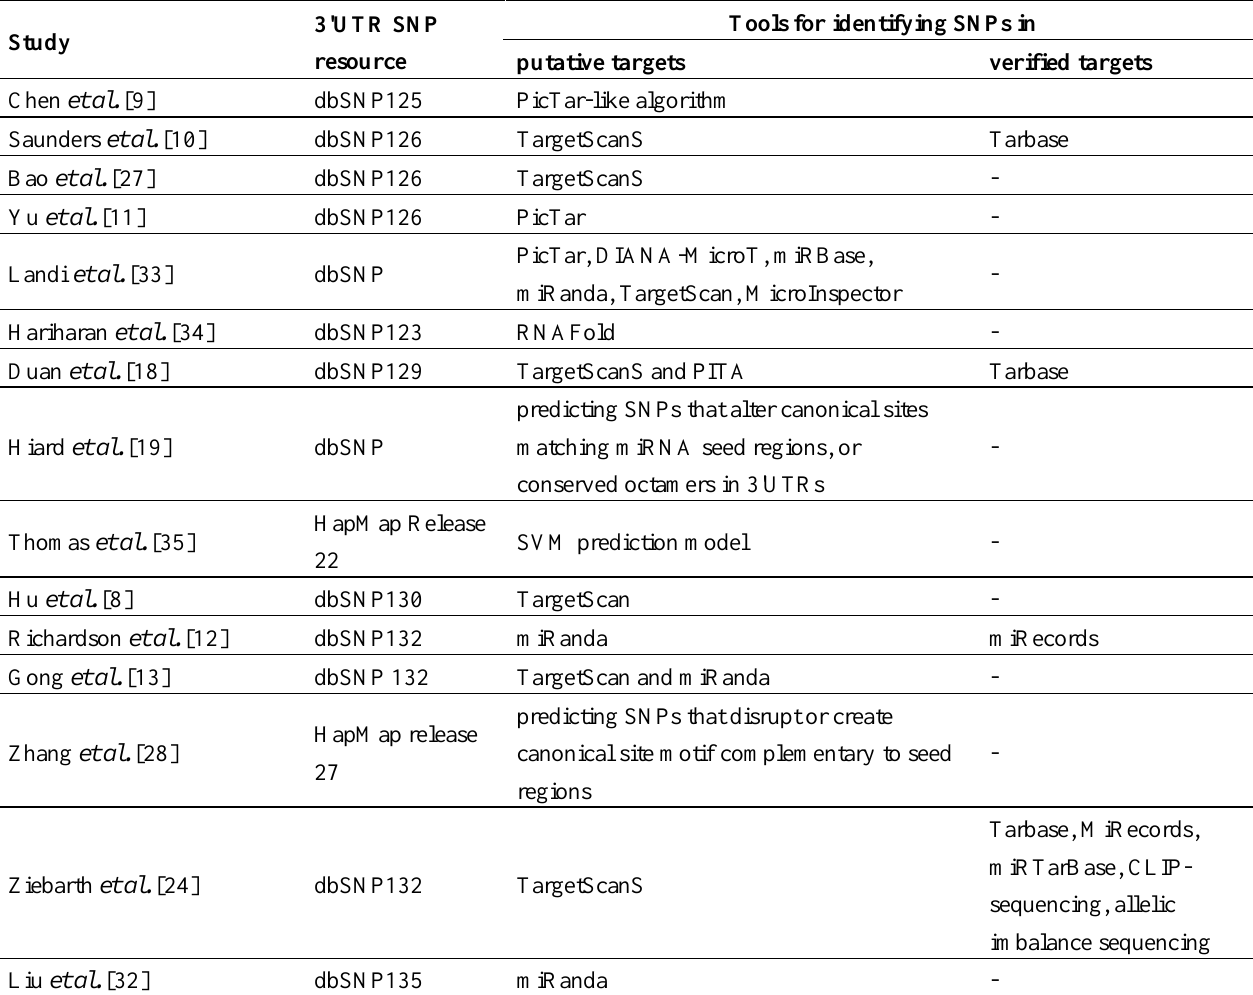
Table 2. Summary of Studies on SNPs in miRNA